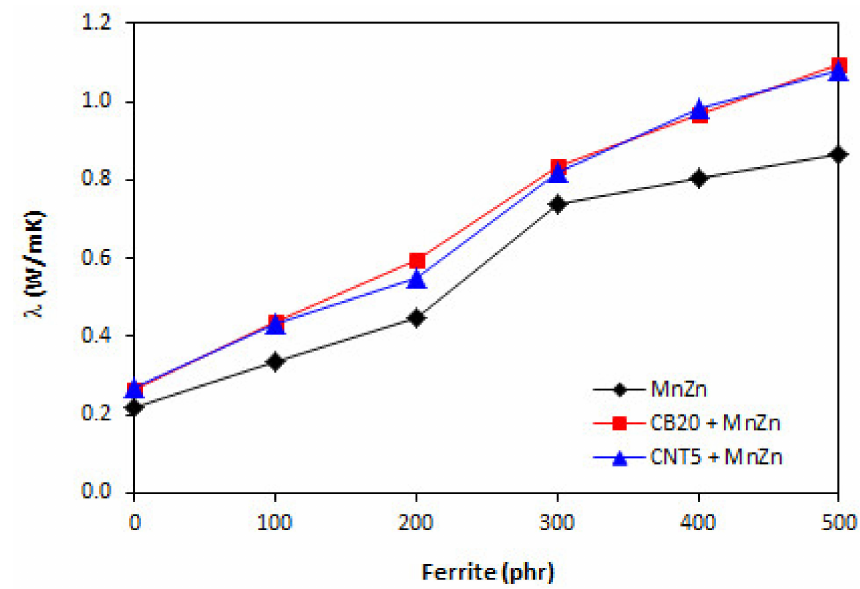
Figure 11. Thermal conductivity coefficient λ of composites.